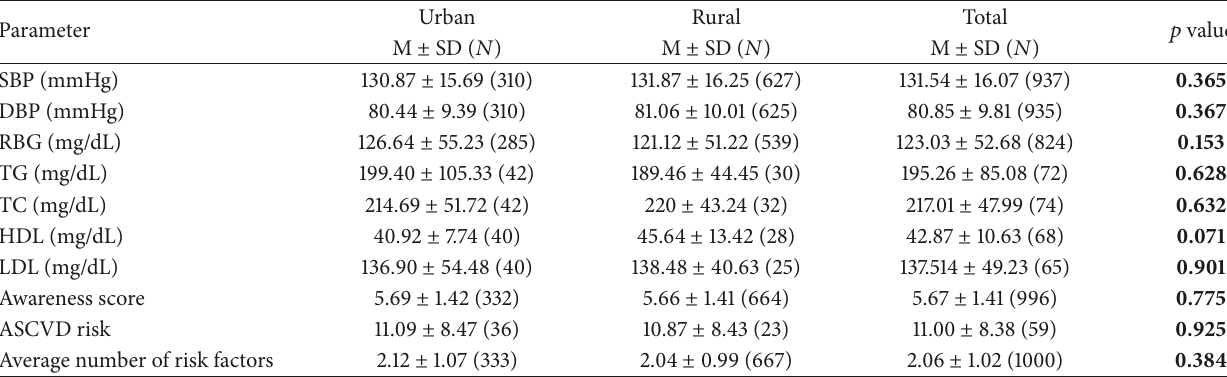
Table 3: Average of measured and biochemical parameters at baseline.